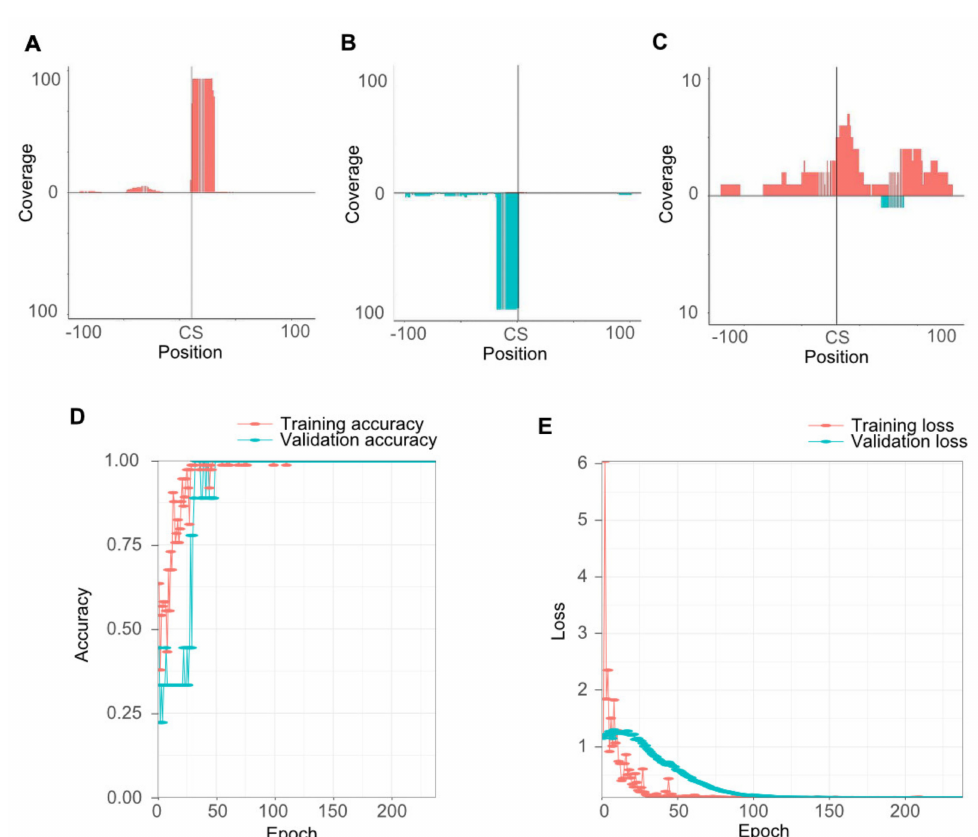
Figure 1. Training of cleavage recognition. ( A ) Cleavage plot displaying a true cleavage at the 5 (cid:48) Whatson strand. ( B ) Cleavage plot displaying a true cleavage at the 3 (cid:48) Crick strand. ( C ) Cleavage plot displaying false cleavage at the 5 (cid:48) strand. Reads on the 5 (cid:48) strand in red and on the 3 (cid:48) strand in blue. CS = Proposed cleavage site by PAREsnip2. ( D ) Training accuracy (red) and (validation accuracy) per epoch of the final convolutional neural network (CNN) model. ( E ) Training loss (red) and validation loss (blue) per epoch of the final CNN